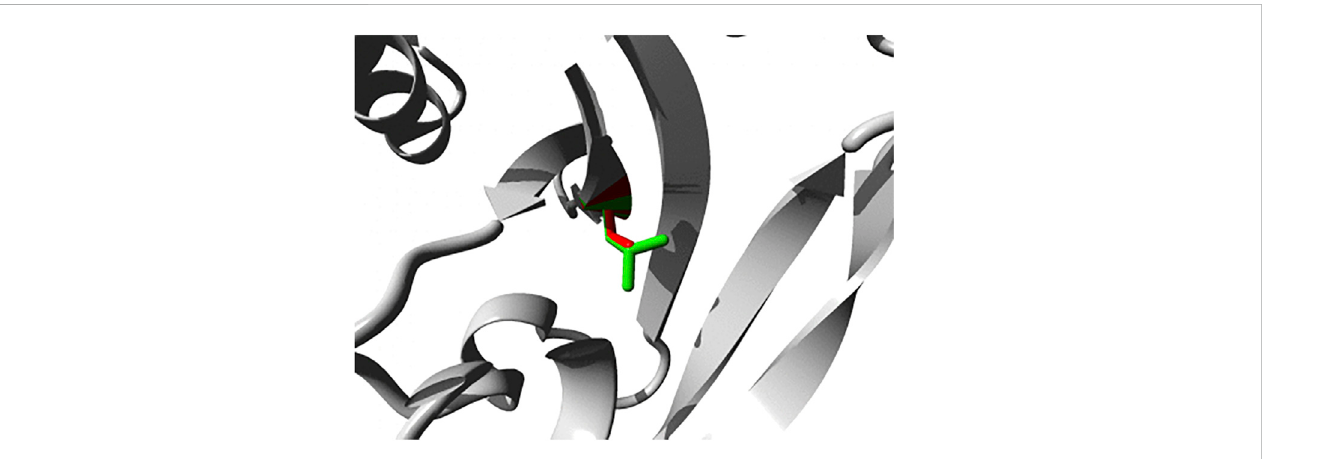
FIGURE 2 Close-up of the p.L72S mutation within the FERM domain of PTP-MEG1. Both the wild-type and mutant side chain are shown in green and red, respectively. The direct surrounding of the protein is shown in grey. Image was generated using HOPE (Venselaar et al.,